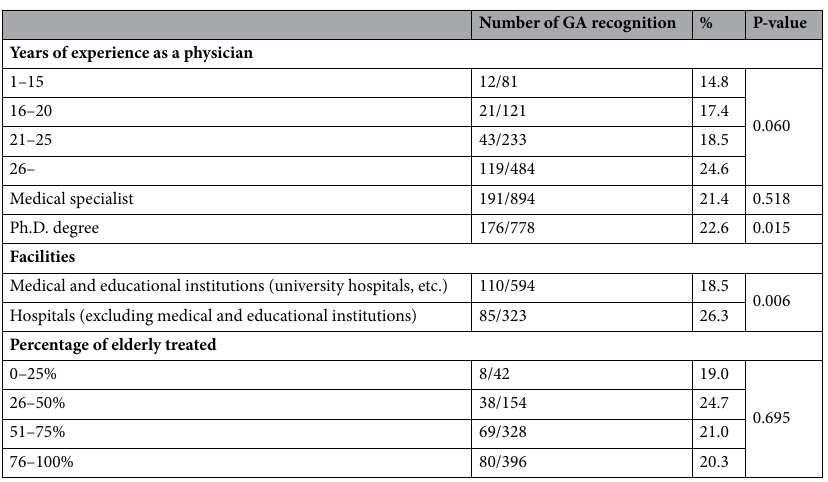
Number of GA recognition %